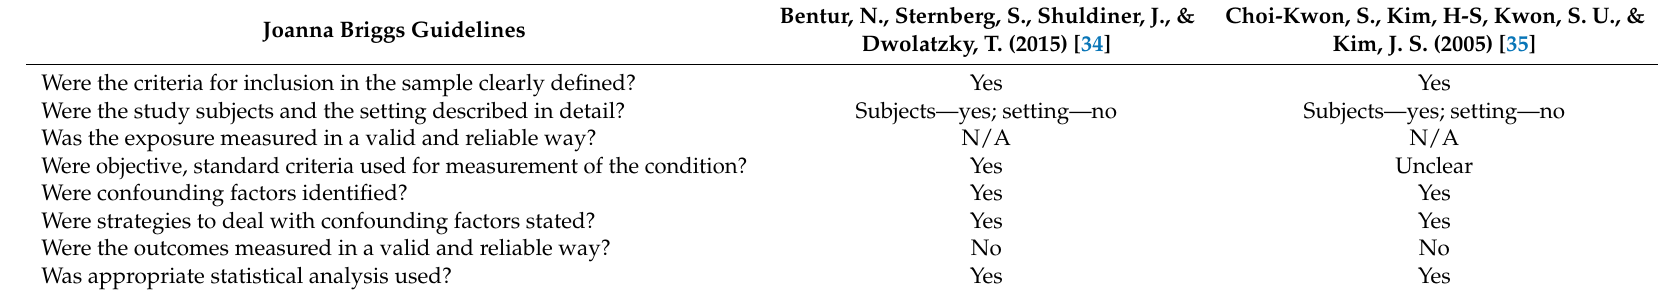
Table 2. Joanna Briggs Institute risk of bias ratings for cross-sectional studies [31]. Joanna Briggs Guidelines